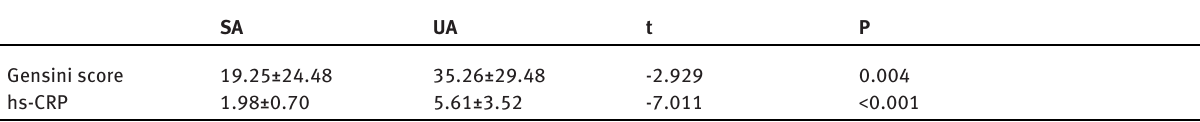
SA UA t P Gensini score hs-CRP